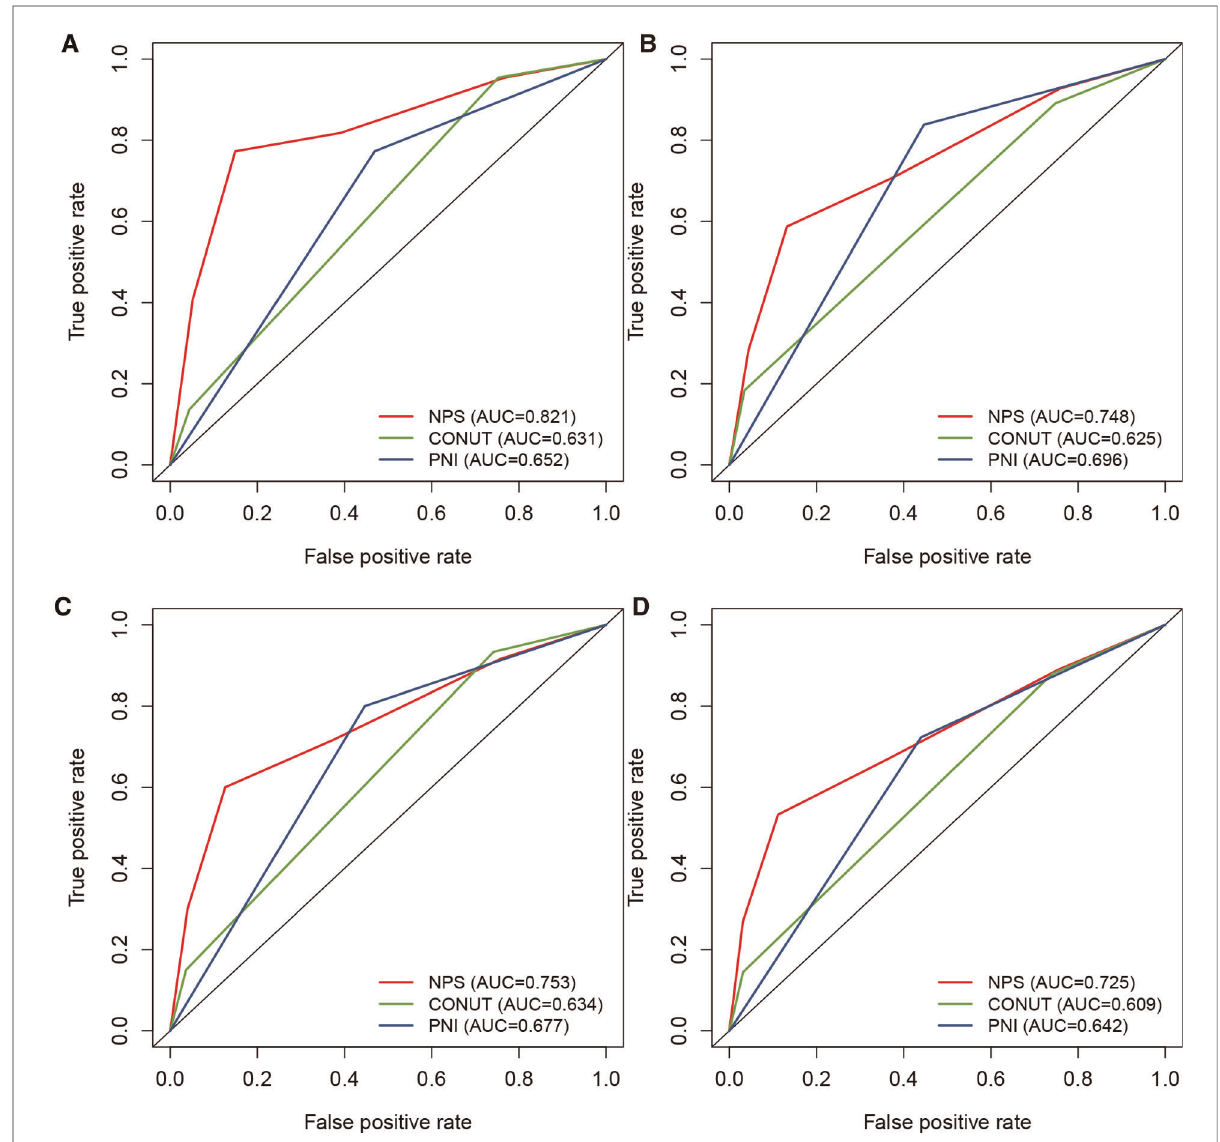
FIGURE 3 ROC curves revealing the discriminatory power of NPS, CONUT, and PNI indexes for predicting ( A ) 1-year OS, ( B ) 1-year PFS, ( C ) 3-year OS, and ( D ) 3- year PFS. OS, overall survival; PFS, progression-free survival; NPS, Naples prognostic score; CONUT, controlling nutritional status; PNI, prognostic nutritional